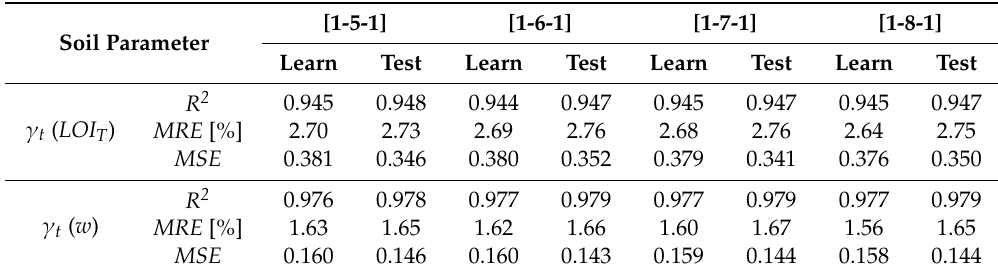
Table 5. The goodness of fit of the ANN models with one